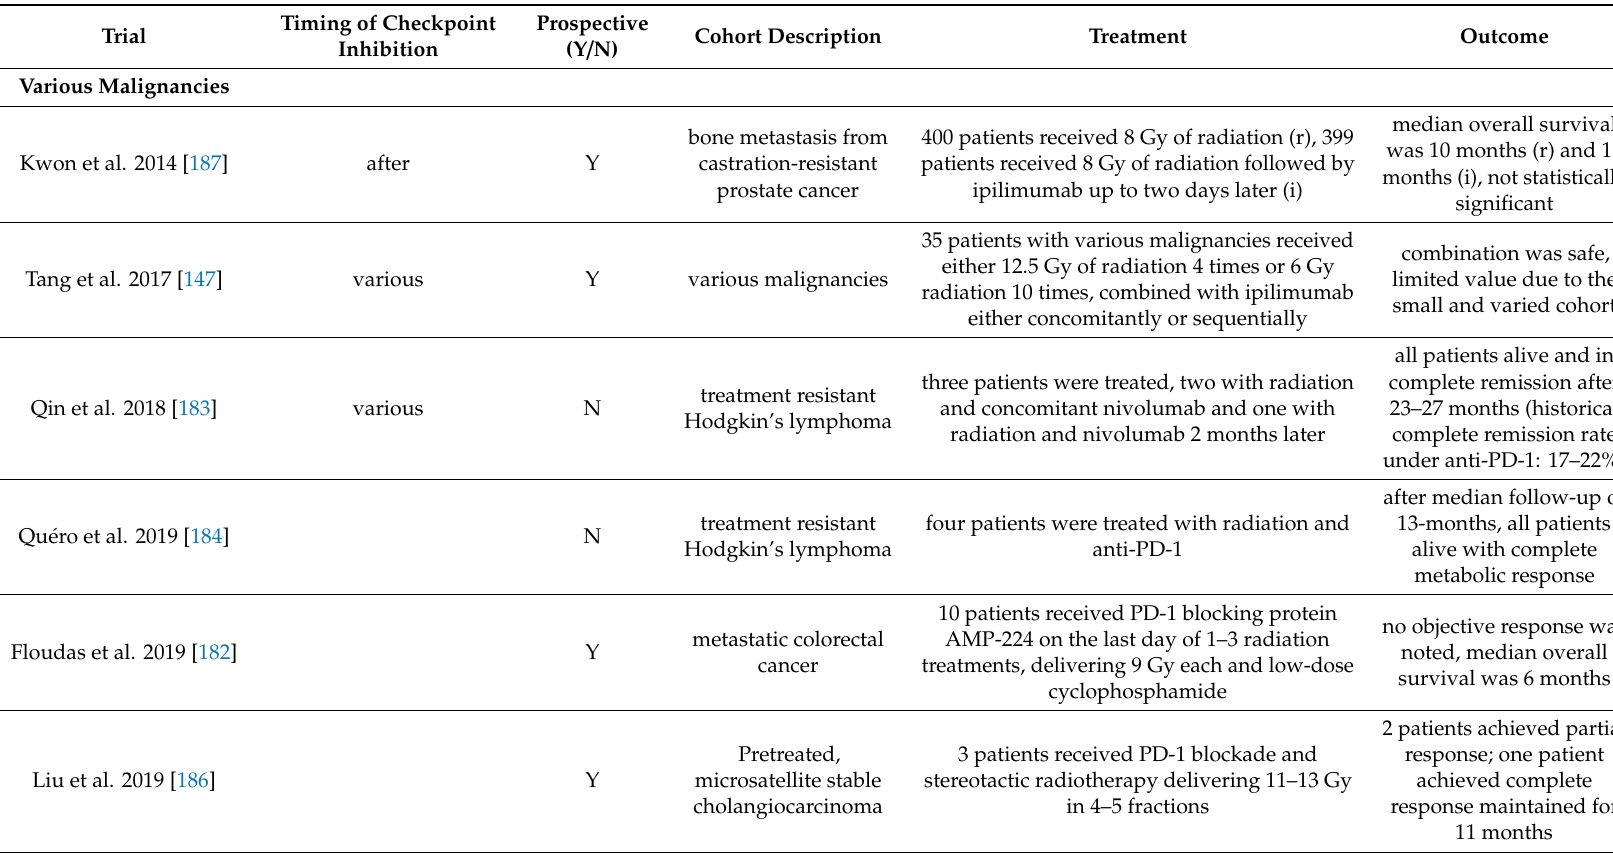
Table 6. Overview of clinical trials concerning combination radiotherapy and immunotherapy in various malignancies. Clinical trials are sorted primarily by cancer and treatment setting, secondary criteria being chronological. Short descriptions of patient collective, treatment, and outcome are